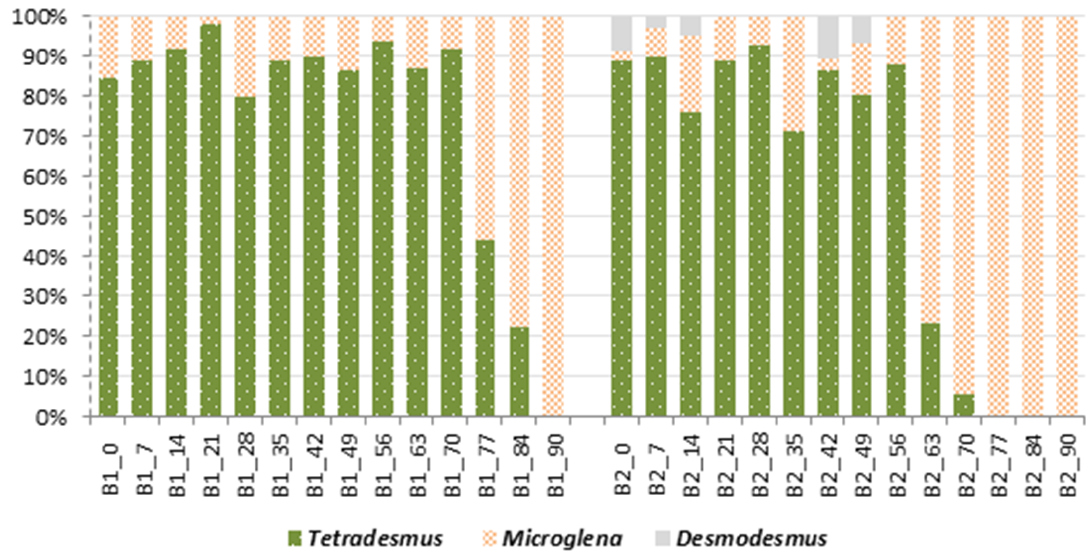
Figure 7. Percentage share of taxa in bioreactors during biological treatment; bioreactor B1 and B2 with the subsequent days of